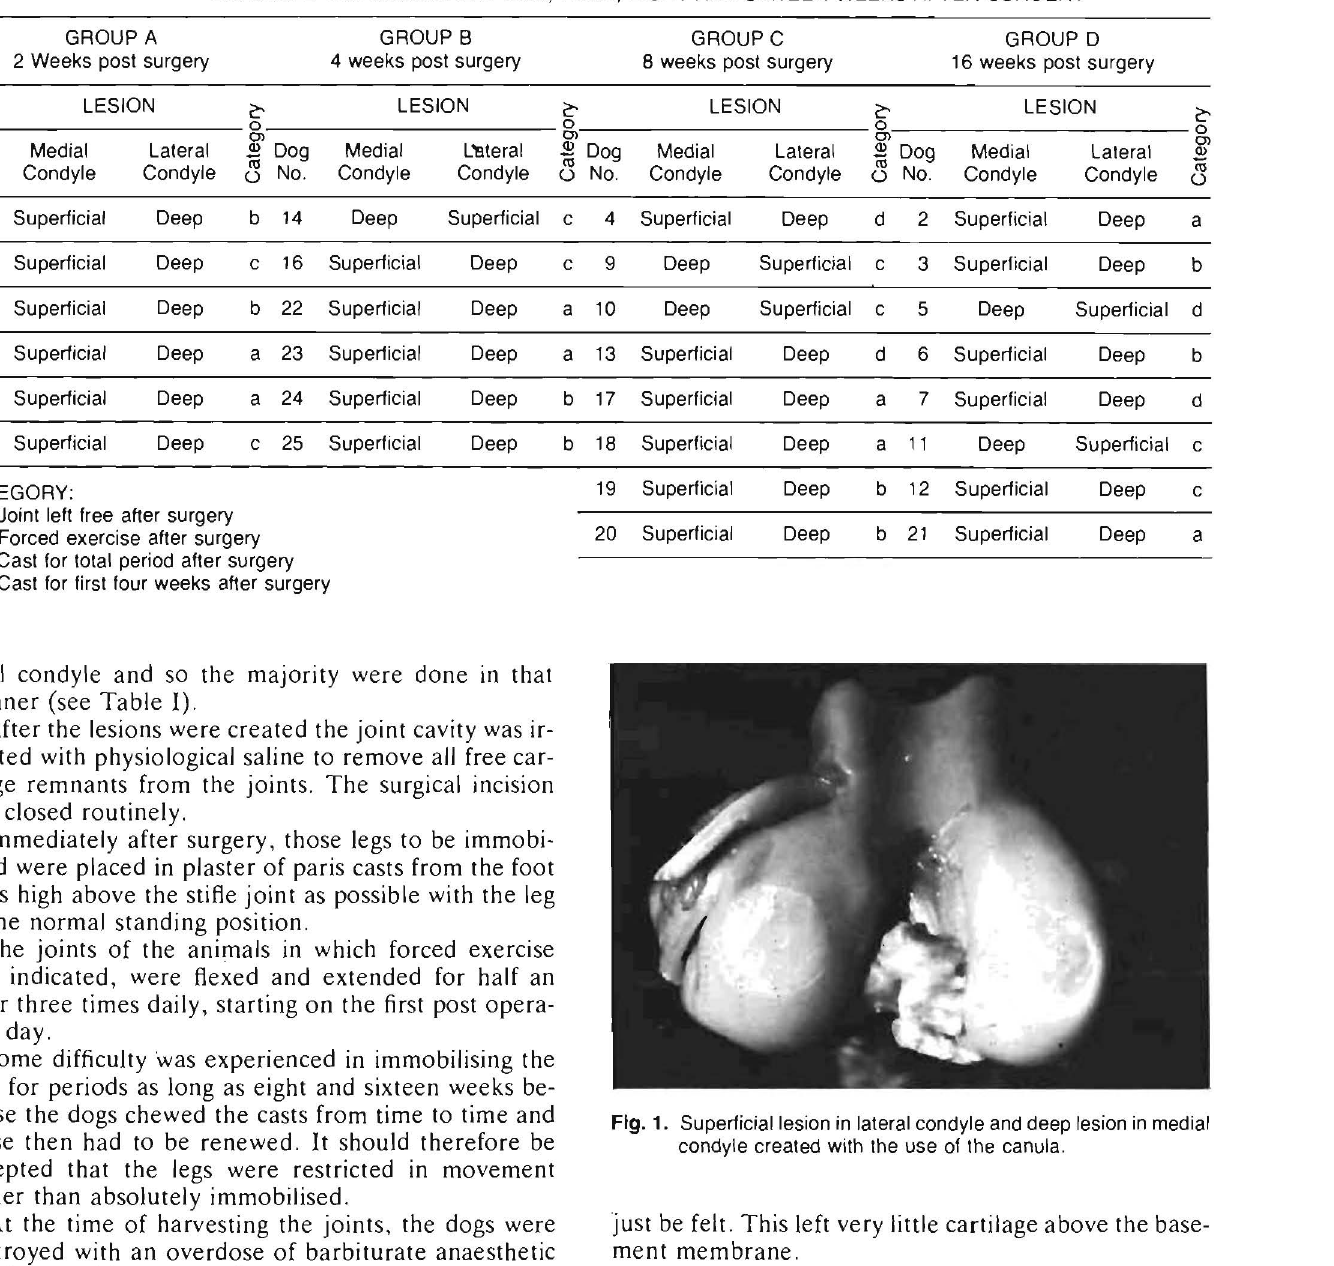
Fig. 1. Superficial lesion in lateral condyle and deep lesion in medial condyle created with the use of the canula.